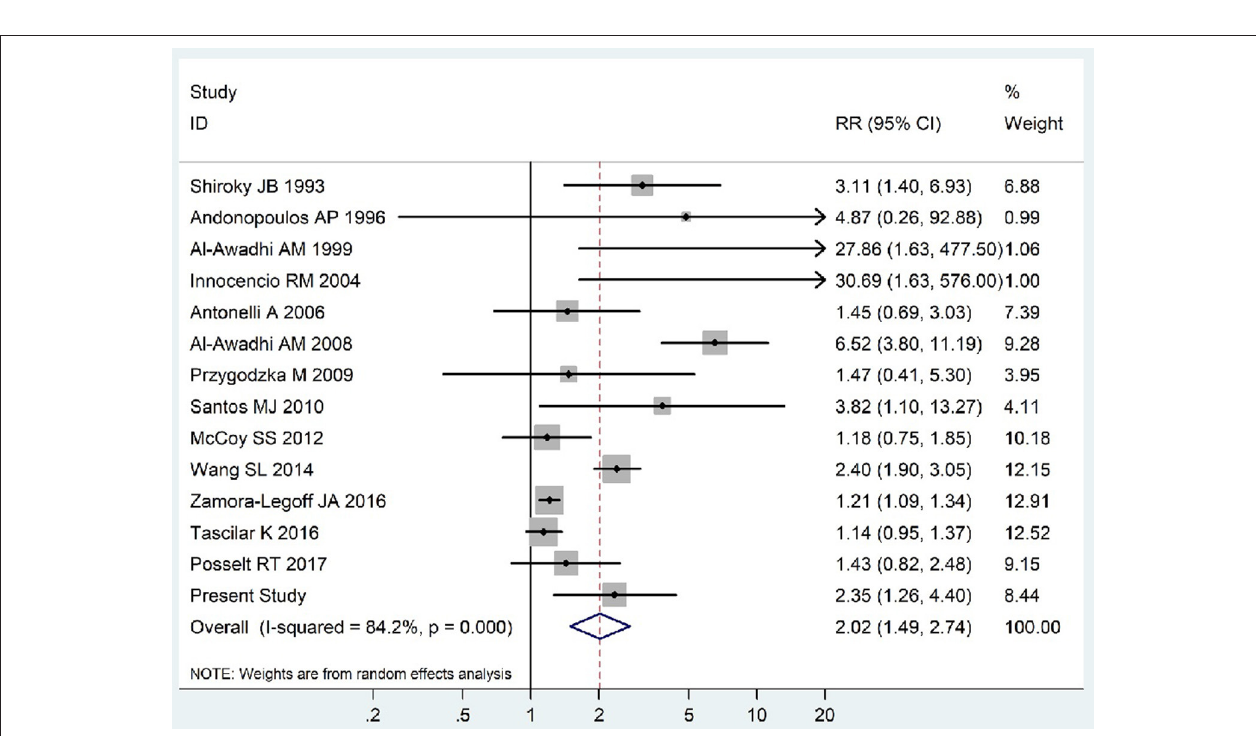
FIGURE 4 | Forest plot for the increased risk of hypothyroidism among RA patients (The diamond represents the pooled RR and 95% CI).